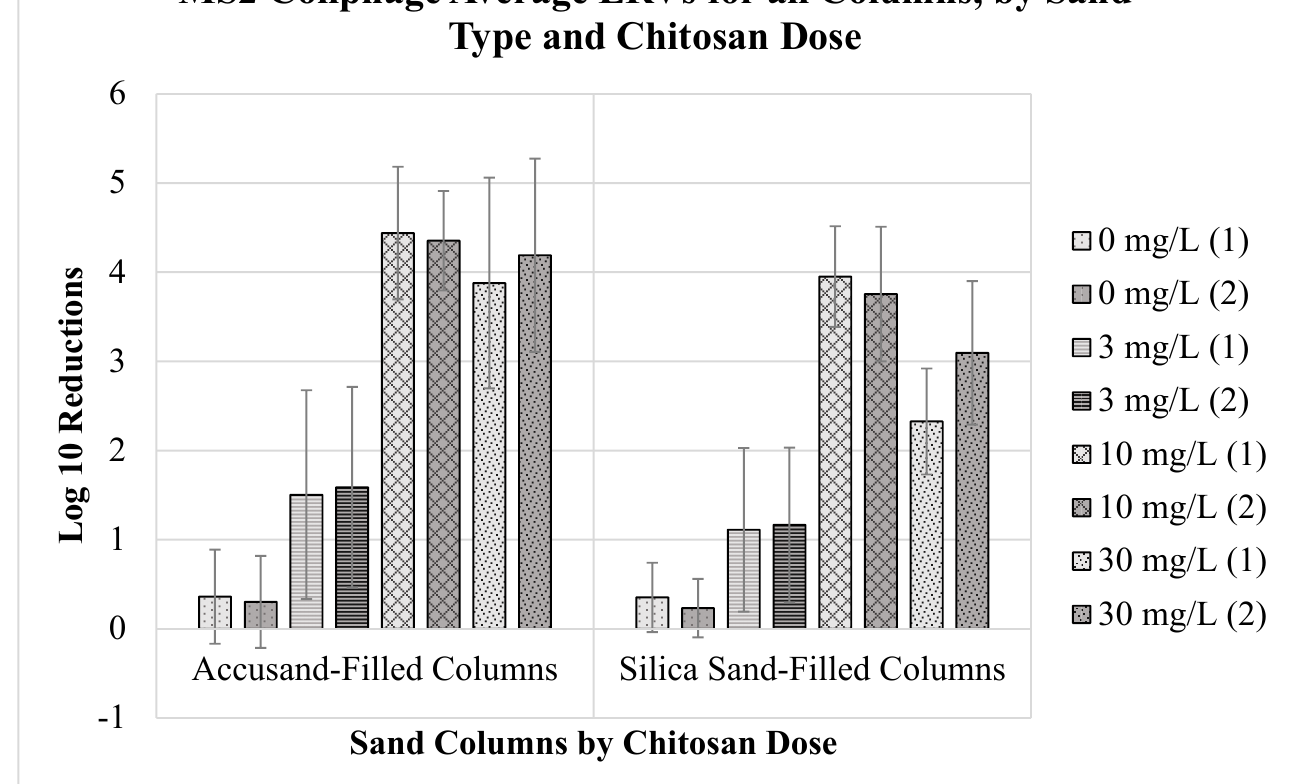
Figure 2. Average log 10 reduction values (LRVs) with standard deviation error bars for MS2 coliphage in water treated by chitosan coagulation and Accusand and silica sand column filtration, based on 17 successive samples collected throughout the 57-day experiment period.